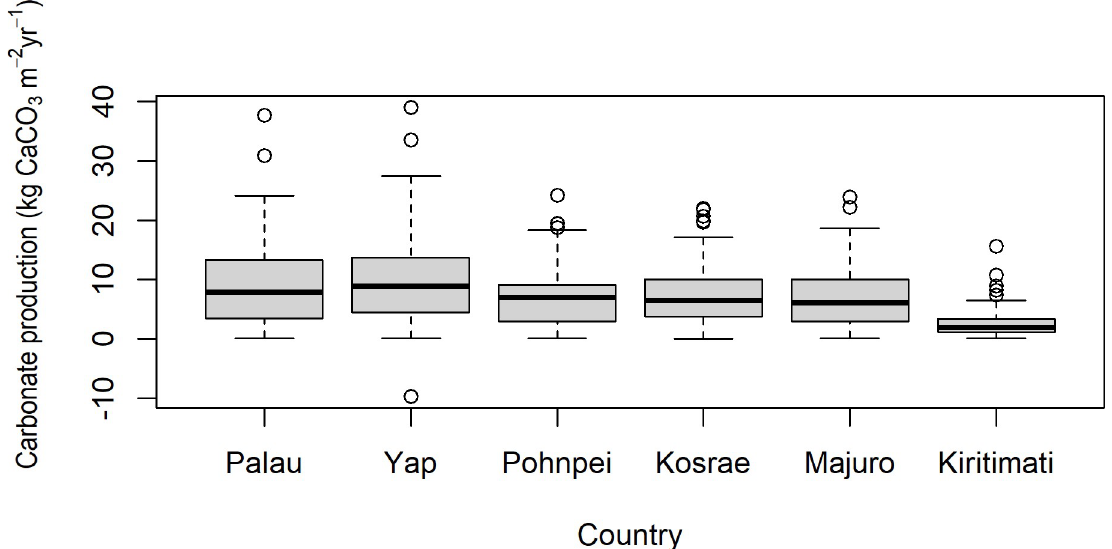
Fig 4. Carbonate production rates (kg CaCO 3 m -2 yr -1 ) of shallow coral reefs in the tropical Pacific Ocean, stratified by island for Palau and Yap (2017), Pohnpei and Kosrae (2018), and Majuro and Kiritimati (2019). The thick horizontal lines are the medians, the boxes surrounding the medians are the first and third quartiles, the whiskers identify the range of the data, and the circles identify the outliers.